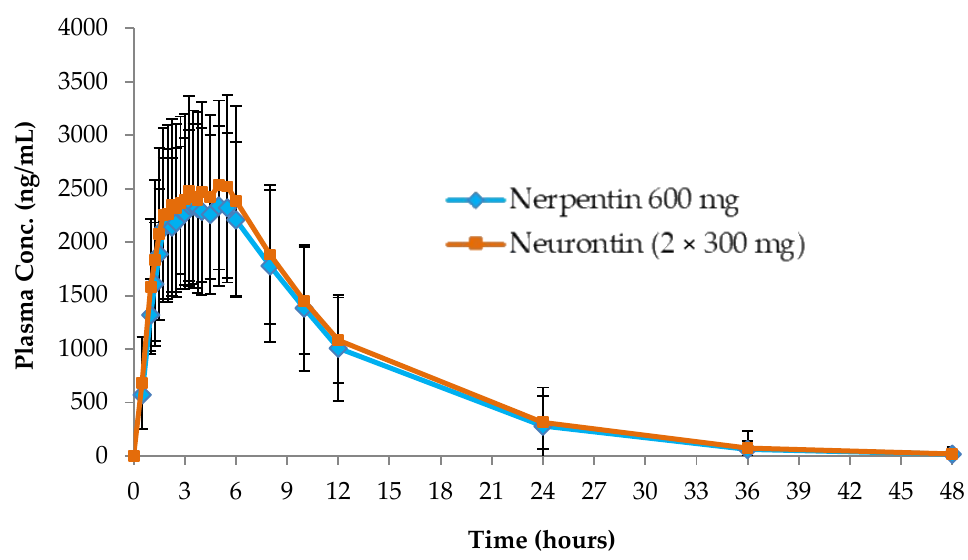
Figure 5. Mean human plasma concentration–time outline after intake of one film-coated tablet (test product, Nerpentin 600 mg of GAB/tablet), and two hard gelatin capsules (300 mg of GAB/capsule).